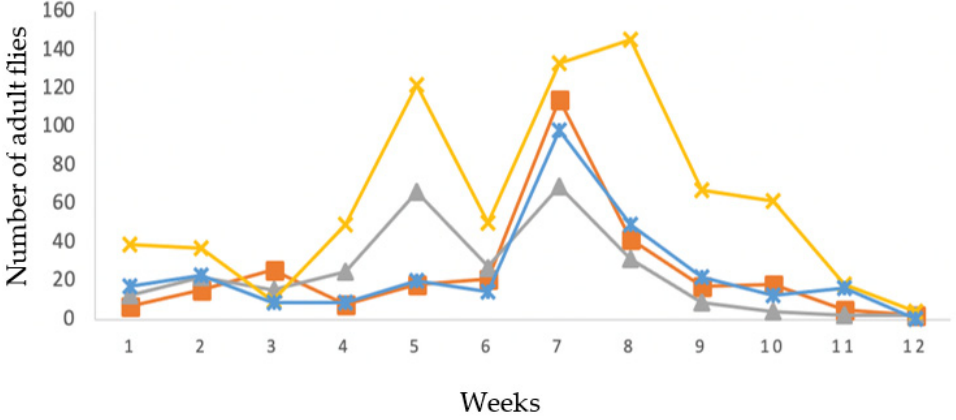
D. suzukii in the blueberry field using Suzukii ® bait trap in 2017.